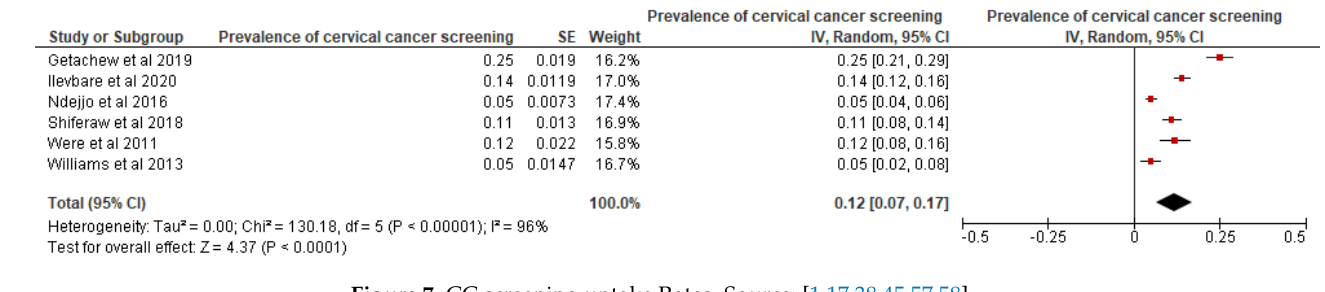
Table 3. Barriers to CC screening uptake.